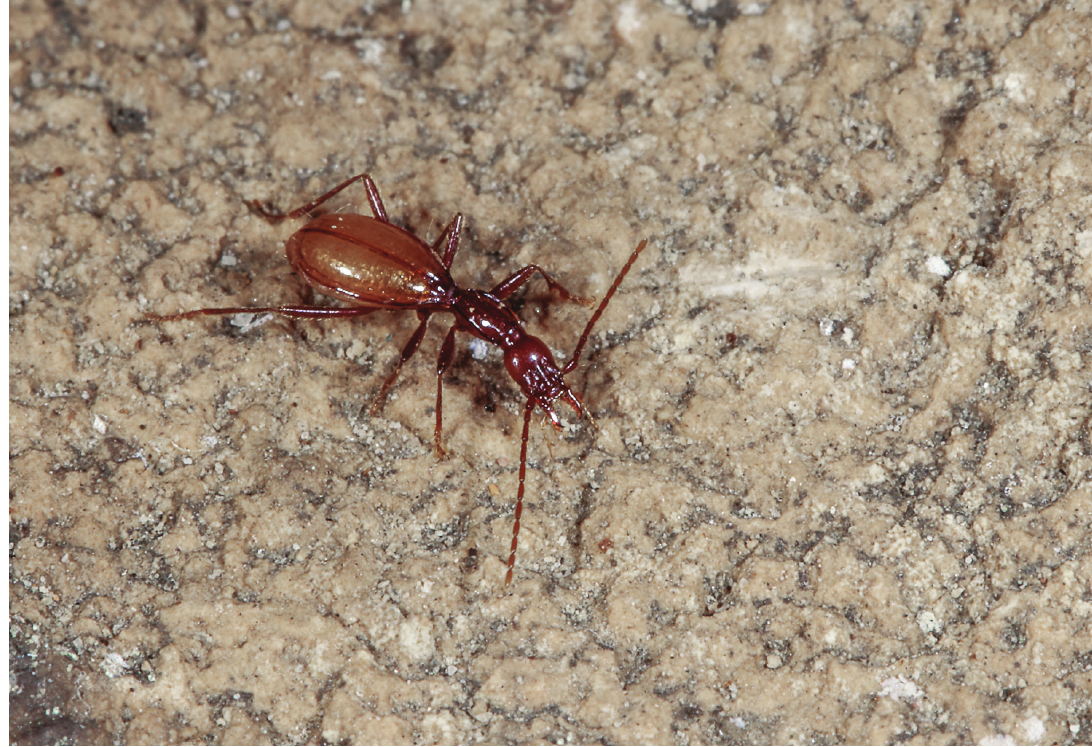
(white label, printed) / “DNA extraction XA475” (white